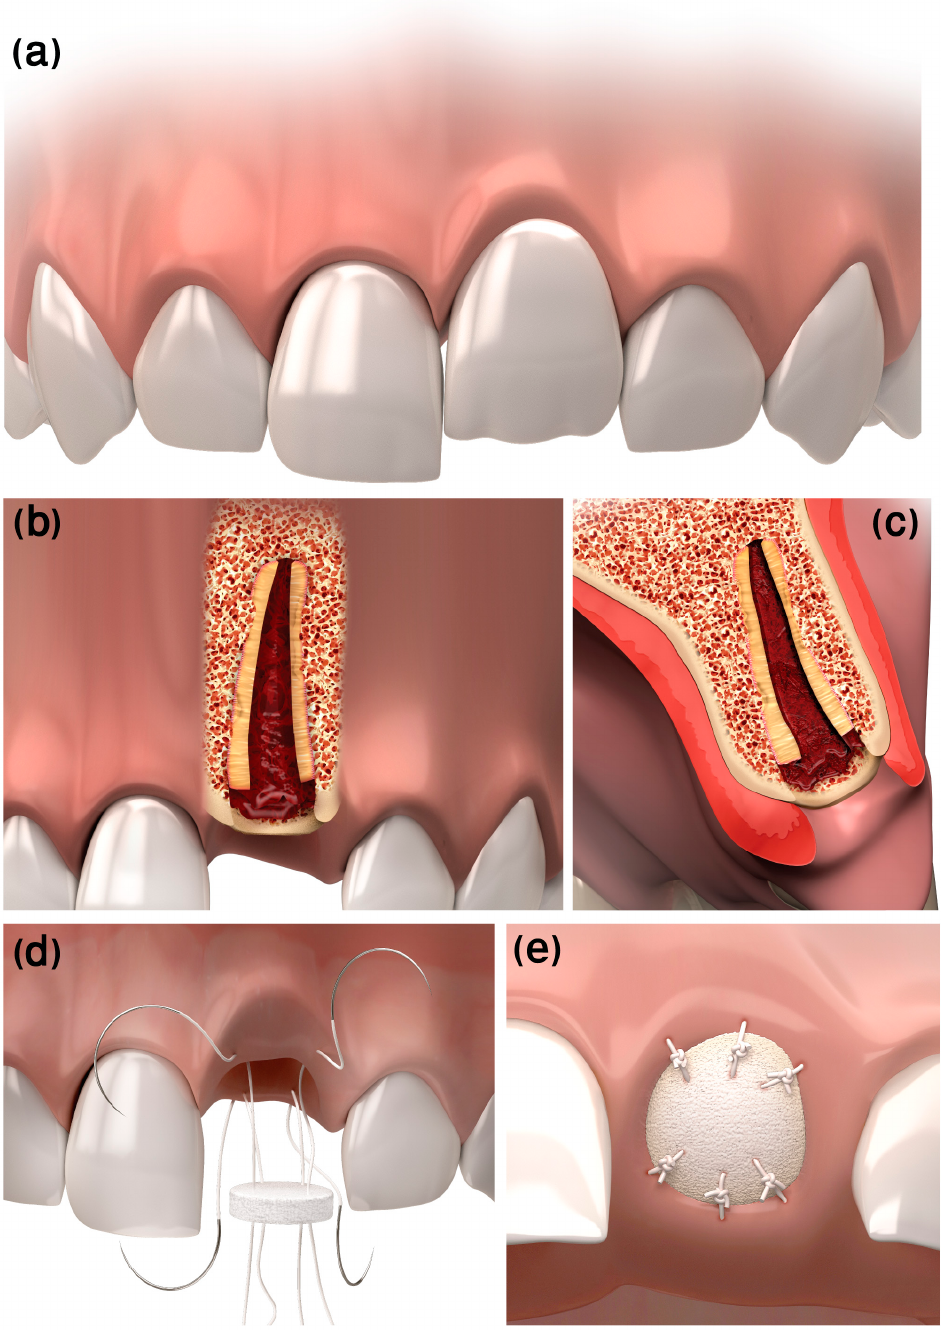
Figure 1. Flapless decoronation illustration. ( a ) Pre-op ankylotic infrapositioned left central incisor. ( b ) Coronal and ( c ) sagittal cross-sections of the resected ankylotic root below the marginal bone. Blood is filling the canal space and clotting coronal to the resected root. ( d ) “Parachute” technique suturing. ( e ) Post-op final suturing of the Mucograft ® Seal.